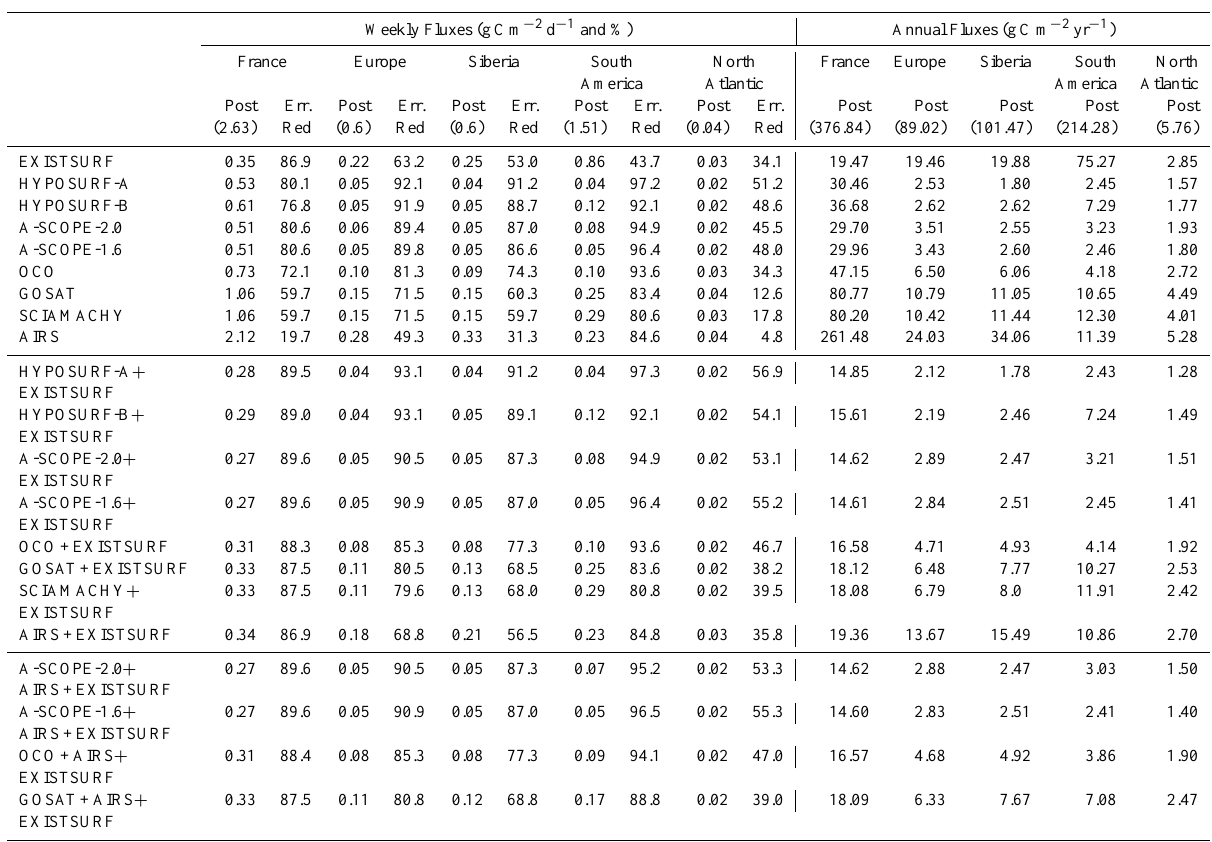
Table 1. Posterior uncertainties (in gCm − 2 d − 1 ) and error reductions (in %) for weekly fluxes and posterior uncertainties (in gCm − 2 yr − 1 ) for annual fluxes for one single region (France) and four selected groups of regions (Europe, Siberia, South America and North Atlantic, north of 30 ◦ N) for all the OSSEs. The prior uncertainty is given in